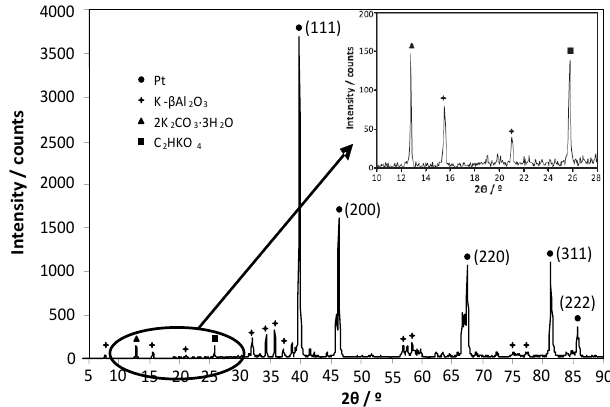
Figure 4. XRD spectra after EPOC experiments (CH 3 OH/O 2 = 7.2%/4.6%, 593 K, overnight at − 2 V) of